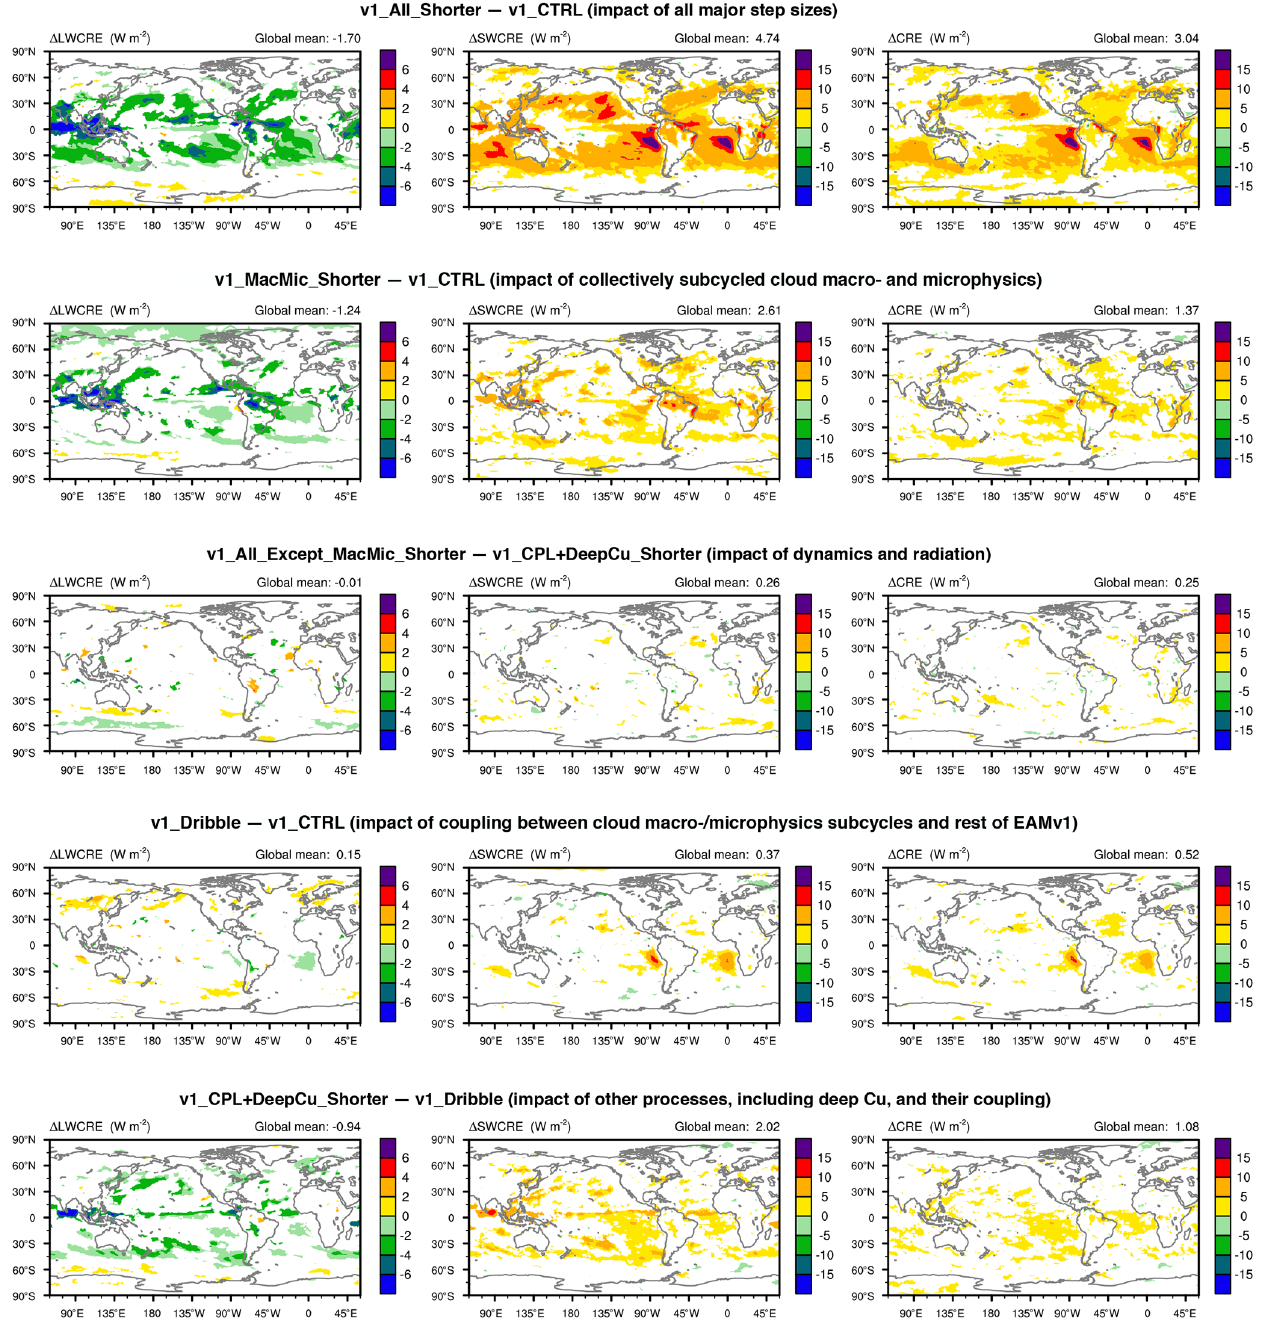
Figure 17. Attribution of the 10-year mean CRE differences between v1_All_Shorter and v1_CTRL (first row) to various components of EAMv1 (lower rows). Left column: LWCRE; middle column: SWCRE; right column: total CRE. White indicates statistically